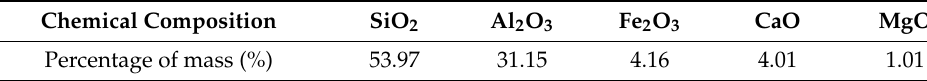
Table 3. Chemical composition of fly ash.